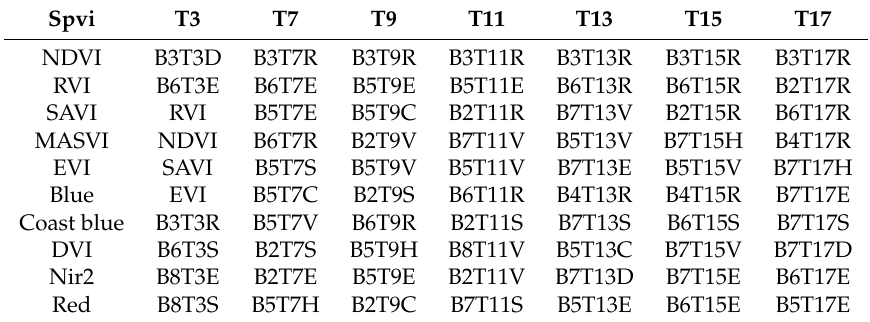
Table 5. Feature factor subsets for mind evolutionary algorithm-back propagation neural network model.